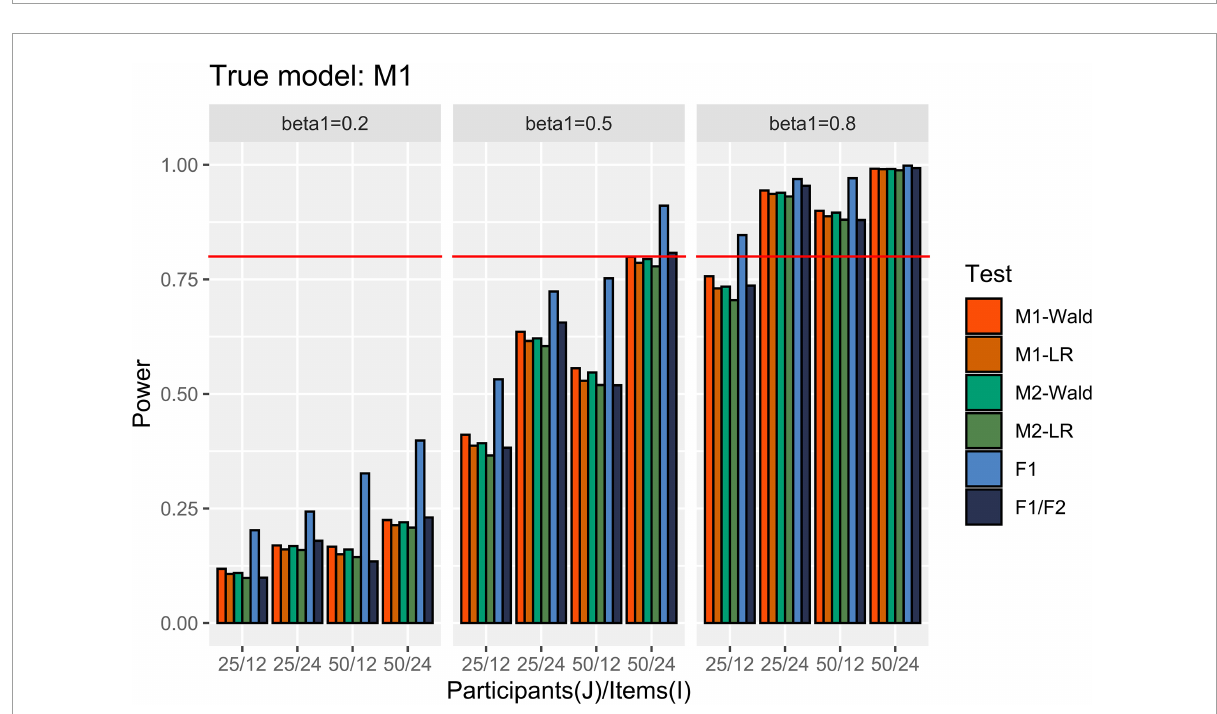
I error rate for all numbers of participants and items. When , ω 2 [ ω 2 ] = [0.05, 0.75] the Type I error rate of M1 exceeded 1 2 0.08 only when the Wald test was used under the condition with